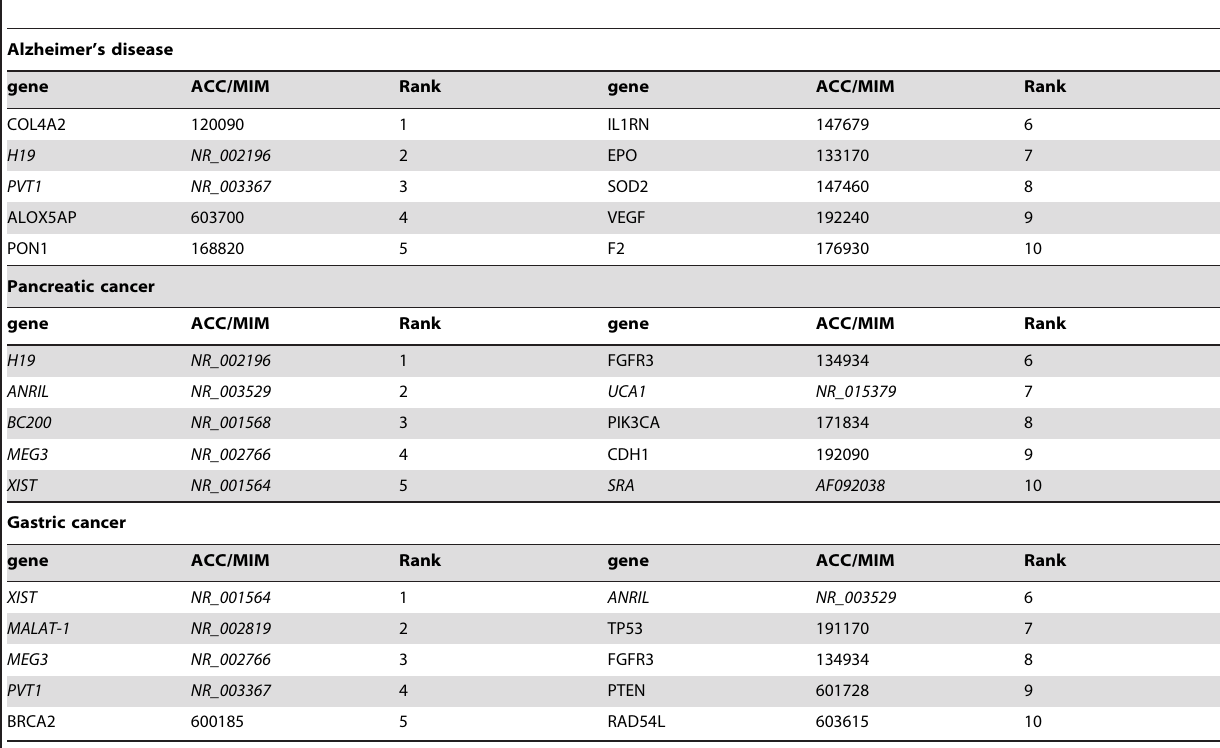
Table 1. The top-10 ranked genes for three case